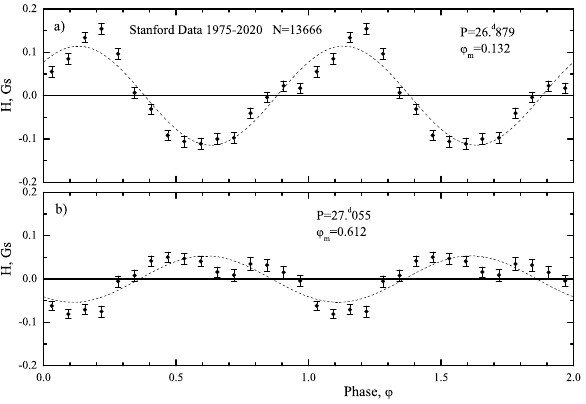
Figure 4. The phase curves for the periods: a) P = 26 d .879 and b) P = 27 d .055. Number of the phase intervals is 16. The dashed line shows the approximation of the data by a sinusoid, the phase of the maximum of which φ m is indicated in each